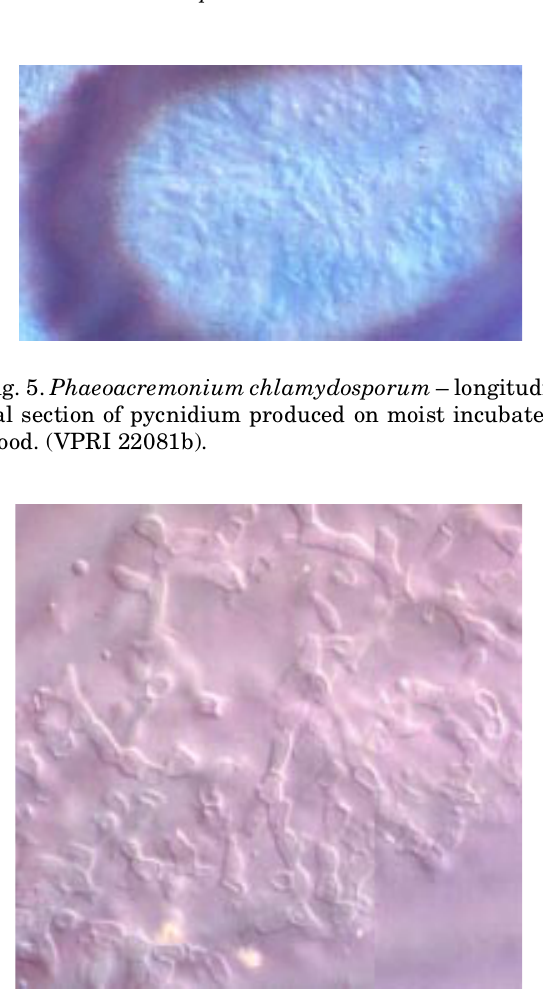
Fig. 6. Phaeoacremonium chlamydosporum – conidiog- enous cells from squash preparation of pycnidium (VPRI